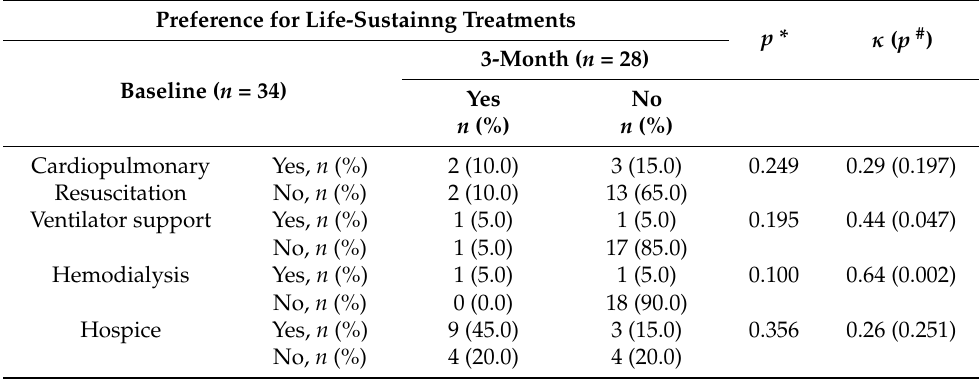
Table 2. Baseline-to-3-month concordance of the preferences for life-sustaining